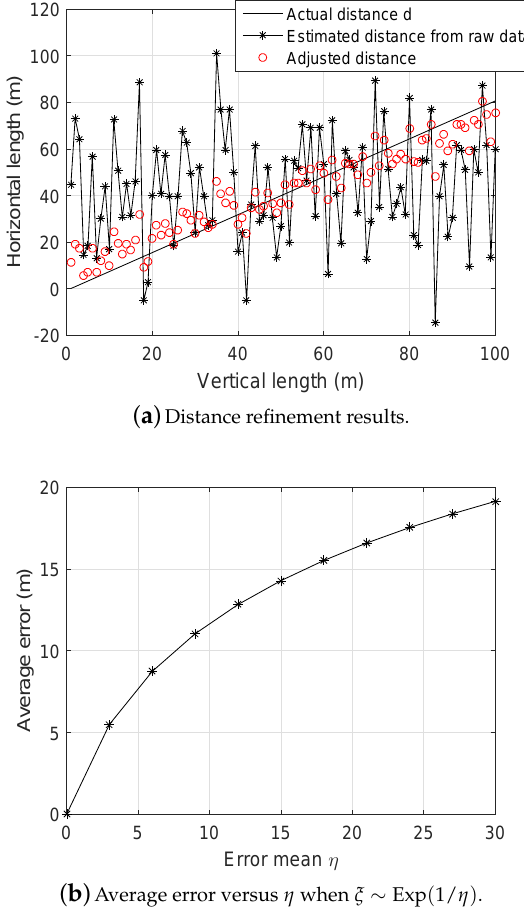
Figure 3. Examples of distance calibration. ( a ) Distance refinement results; ( b ) Average error versus η when ξ ∼ Exp ( 1/ η )